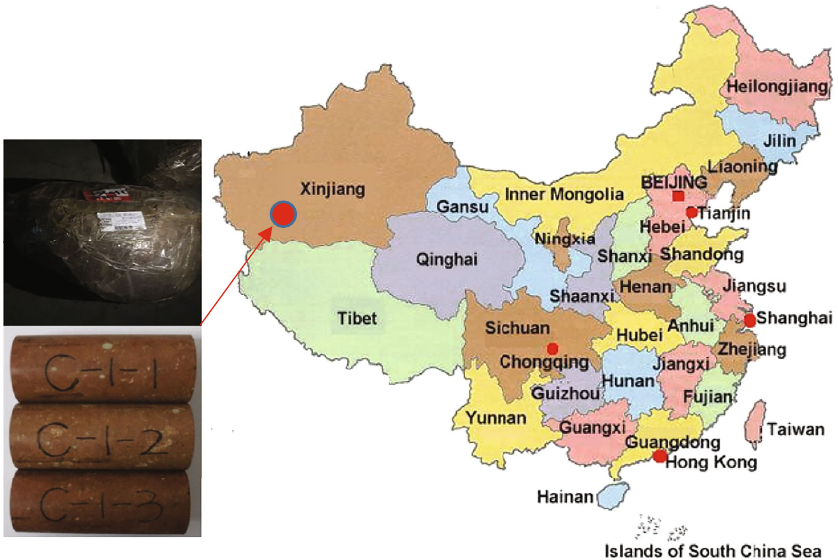
Figure 1: Geographical location of mudstone samples in Xinjiang province, China. Table 1: Analytical results of X-ray di ff raction for mudstone